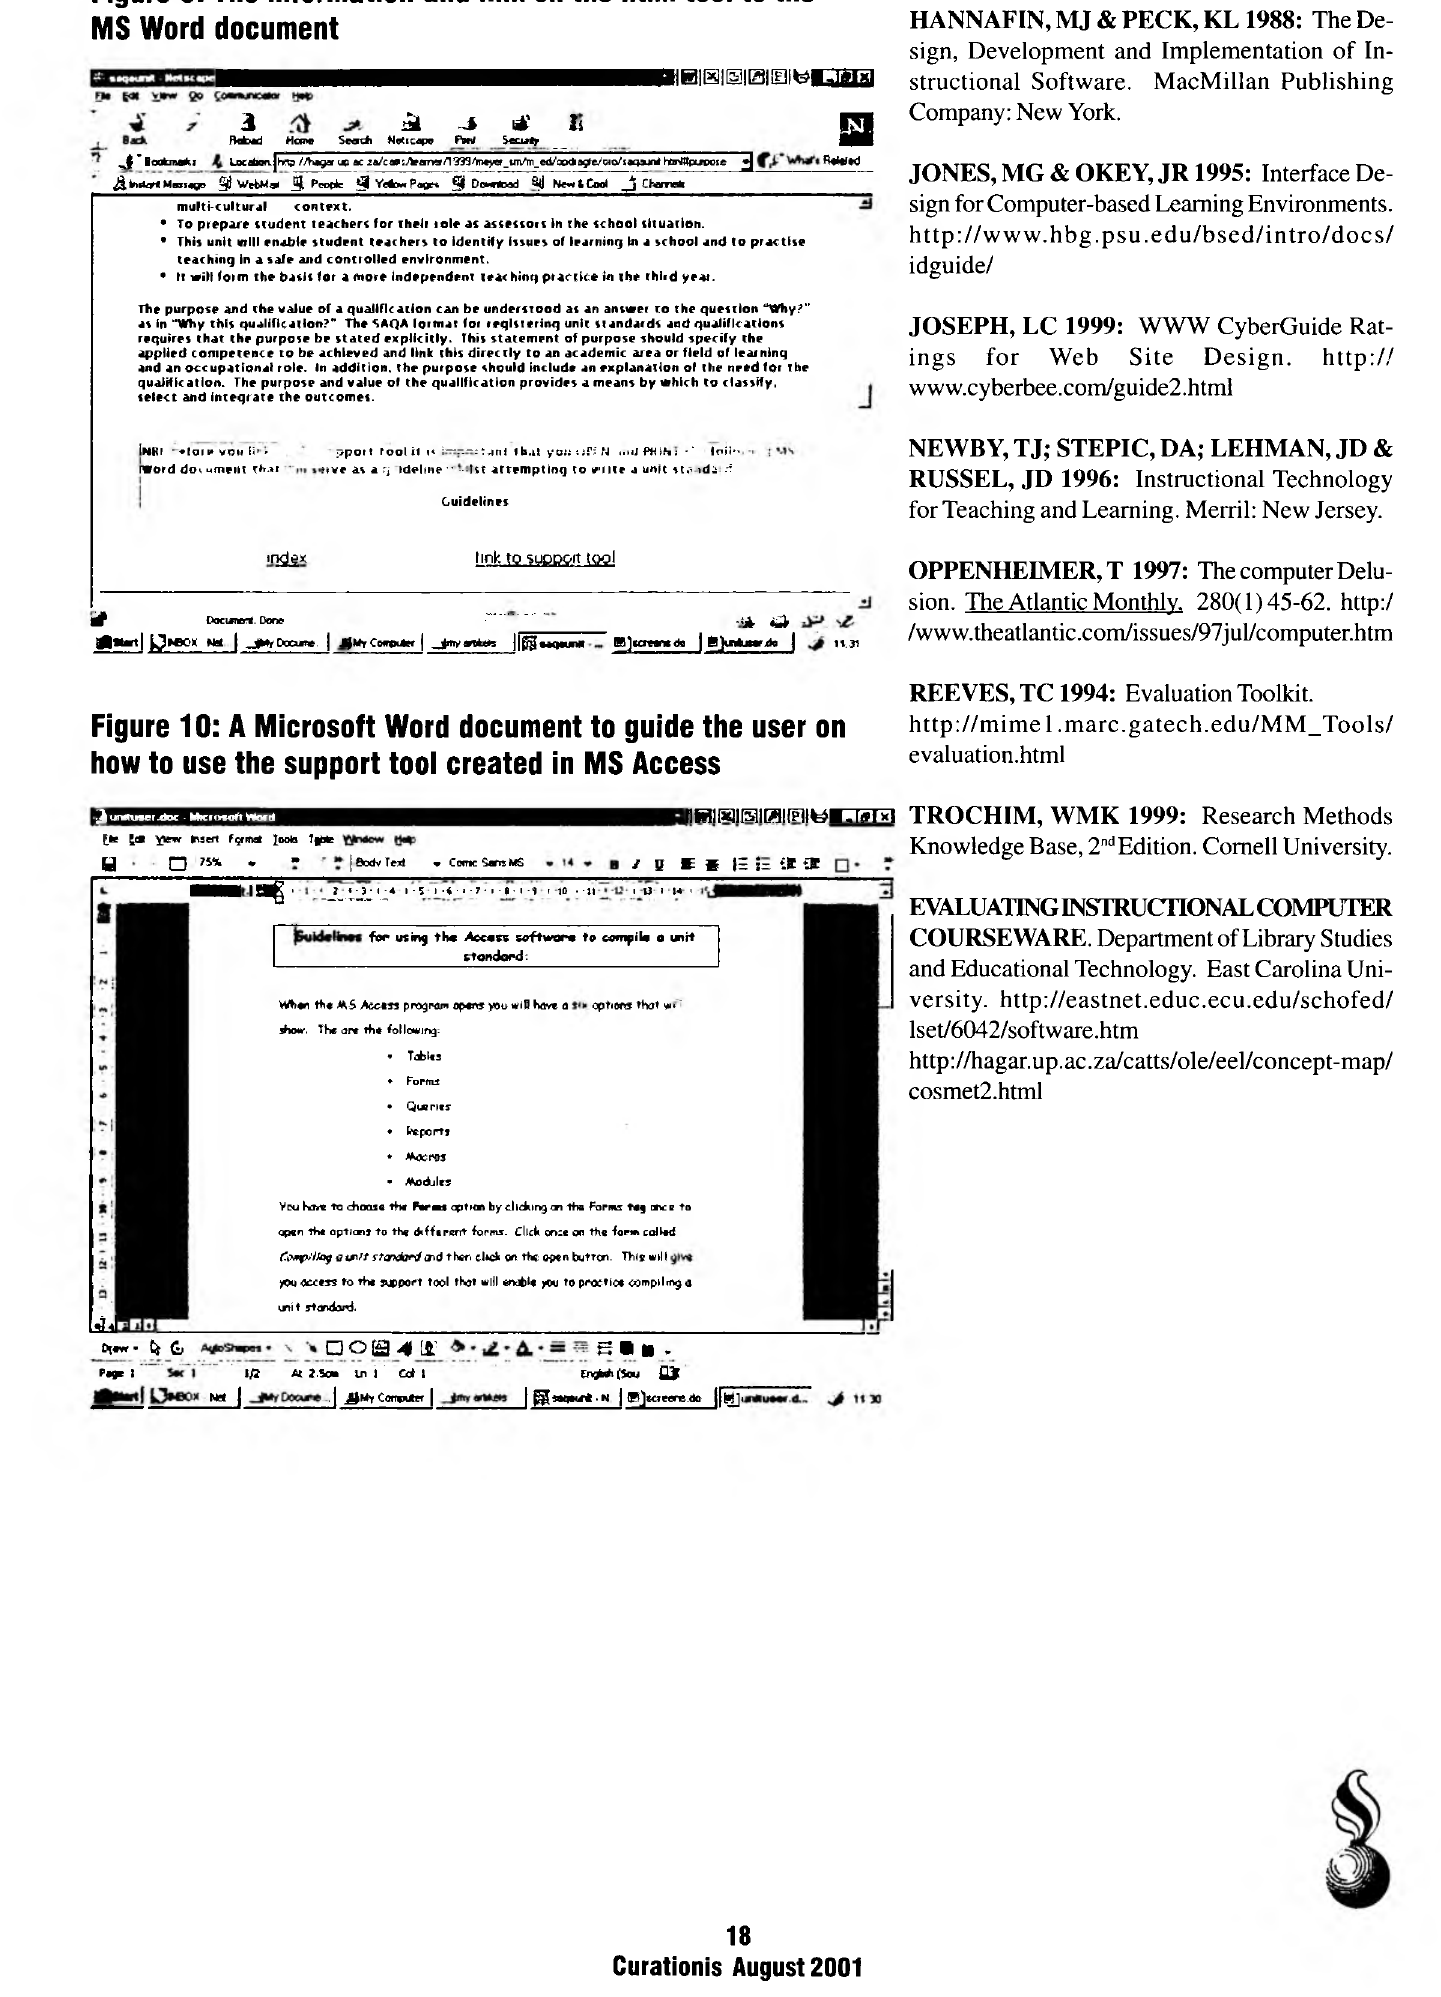
Figure 9: The information and link on the html tool to the